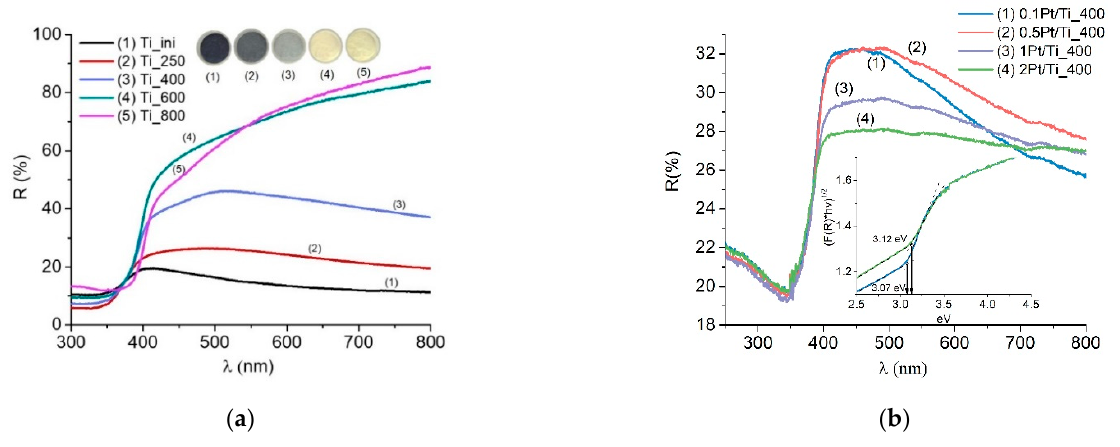
Figure 2. UV-Vis DRS of TiO 2 ( a ) and TiO 2 -Pt ( b ) powders. Based on the above, the samples modified with platinum (Figure 2b) were all an- nealed at a temperature of 400 °C, since such samples possess a crystalline structure.